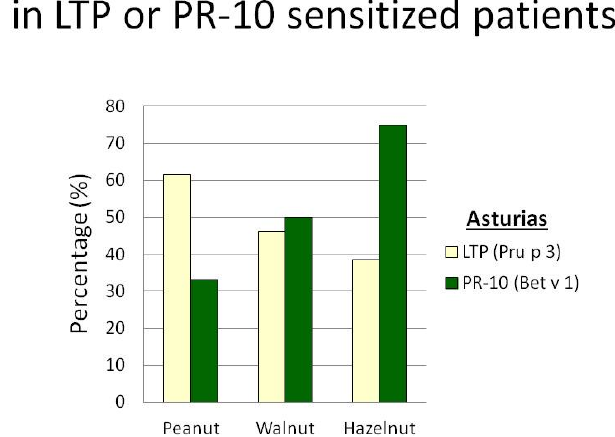
Figure 4. Frequency of nut allergies in patients sensitized to LTP and Bet v 1 from Asturias.